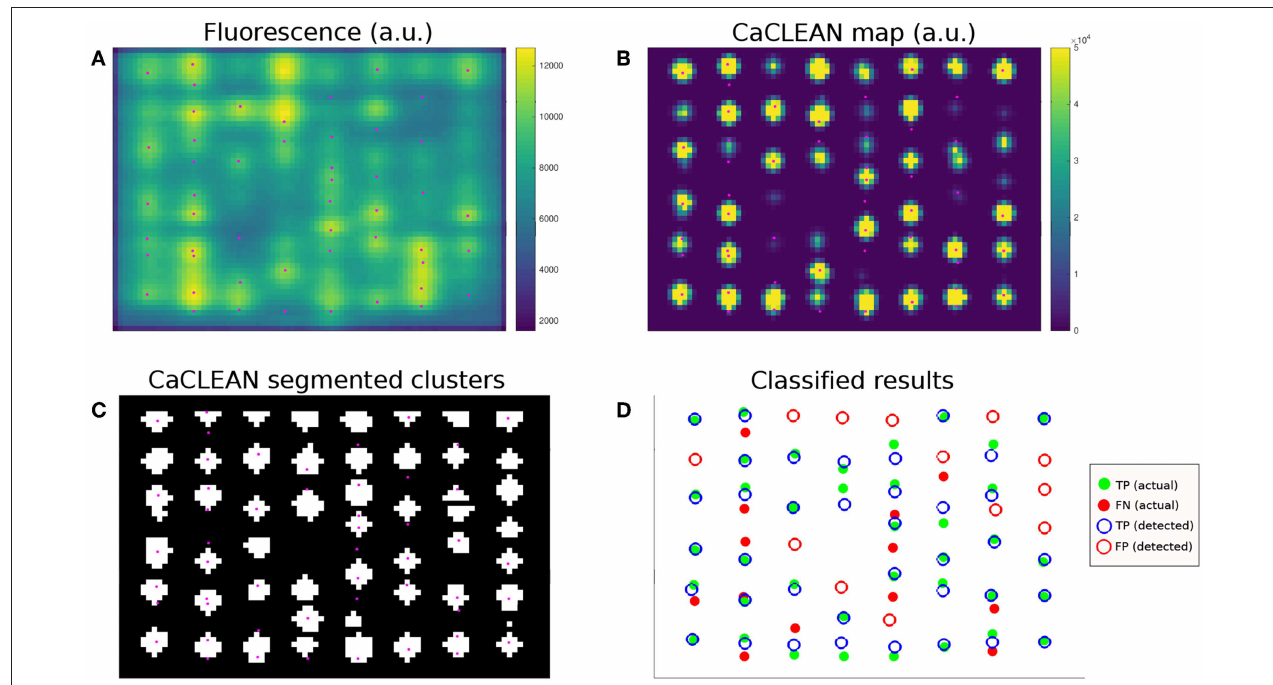
FIGURE 3 | Example of CaCLEAN detection and classification against modeled locations. (A) Simulated confocal fluorescence microscopy image at t = 15 ms for the densely packed cluster case ( N = 123 per z-disk) with mitochondria. This represents one slice from the middle of the stack shown in Figure 2C . Modeled RyR cluster center locations within 280 nm of the imaging plane shown in magenta (also in B,C ). (B) CaCLEAN map of the fluorescence signal. (C) Segmented clusters detected by CaCLEAN. (D) Statistical classification of detected cluster locations vs. actual (ground truth) modeled locations. Modeled release sites are represented by filled dots and detected sites are open circles. A correct detection is therefore represented by a green dot surrounded by a blue circle, while false positives (detection errors) are red circles and false negatives (missed modeled locations) are red